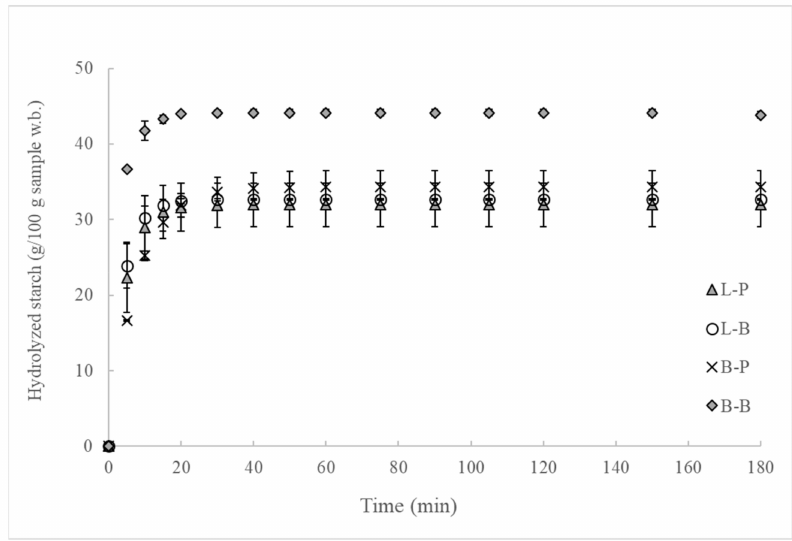
Figure 4. E ff ect of bread structure and simulated oral processing method on starch hydrolysis pattern. Sample names describe the shaping method used (L rolling mill process and B balling process) followed by letters describing the simulated oral processing method applied (P Ultra Turrax and B Ultra Turrax with crystal